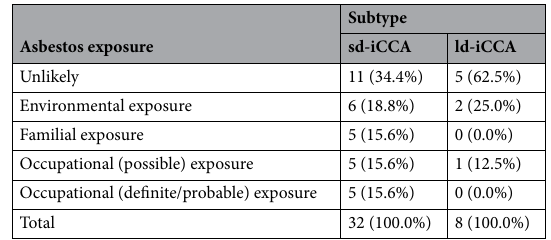
Table 2. Distribution of the small-duct (sd) and large-duct (ld) subtypes of iCCA among enrolled patients according to asbestos exposure categories based on the ReNaM